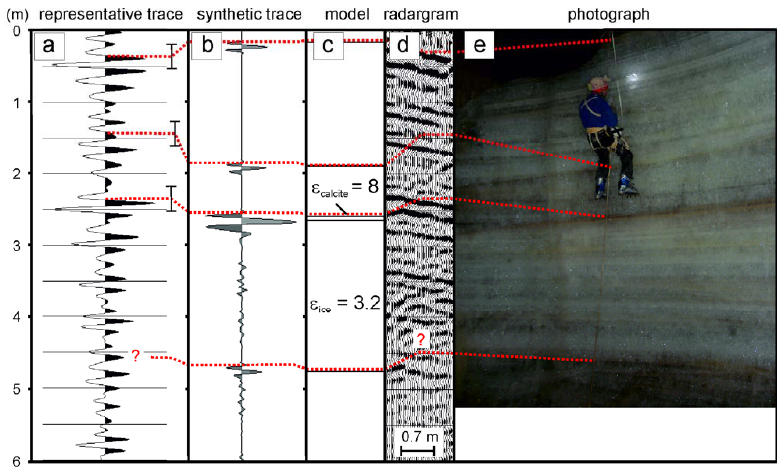
Figure 11: Recorded reflection bands from GPR and synthetic data based on the interpreted layers of calcite powder from the strata taken at the location “Feenpalast 2” (Dachstein-Mammuthöhle): (a) representative GPR signal (stacked trace), (b) synthetic signal, (c) GPR model, (d) recorded reflection bands, (e) photograph. The red lines denote layers which produce significant reflections in the synthetic data and that can be correlated with a) and d). The error bars in a) show the estimated uncertainty of the GPR signal.